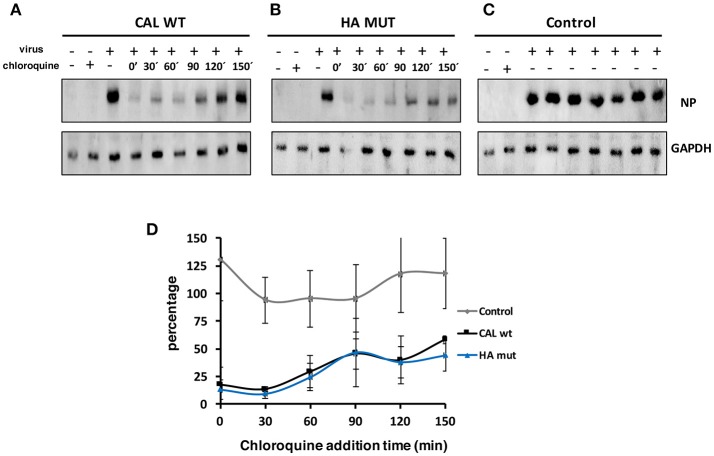
CAL and HA entry in NIH3T3 cells. NIH3T3 cells were infected with 3 pfu/cell with (A) CAL, (B) HA mut, or (C) CAL control viruses and left untreated (–) or treated with 25 μM chloroquine (+) that was added at the indicated times of the infection and was left for 2 h after each indicated time of chloroquine addition. Then, chloroquine was removed and the infection continued until 8 hpi. Infected cells were harvest at 8 hpi and used for NP and GAPDH detection by Western blot. A representative image of each condition is shown. (D) Ratios of NP/GAPDH accumulation in treated cells compared with untreated cells in parts (A,B), or compared with 0 hpi in part (C), of three independent experiments using different viral stocks are shown. NP/GAPDH ratio obtained in cells untreated and infected was taken as 100%. The experiment was performed in triplicates with two different viral stocks. Significance was determined by two-way ANOVA with Bonferroni post-hoc test, (ns) not significant.